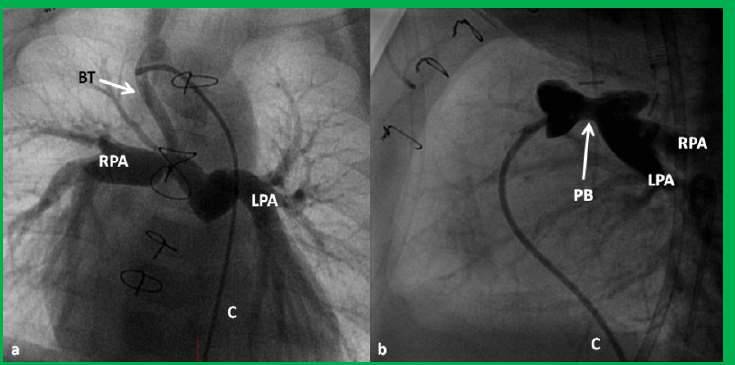
Figure 24. Selected cine frames in postero–anterior ( a ) and lateral ( b ) views, demonstrating a Blalock–Taussig (BT) shunt (arrow in a) to care for infants with decreased pulmonary blood flow ( a ) and pulmonary artery banding (PB) (arrow in ( b )) in babies with increased pulmonary blood flow ( b ), respectively, during Stage I of Fontan procedure. C, catheter; LPA, left pulmonary artery; RPA, right pulmonary artery. Neonates with adequate pulmonary blood flow do not need any intervention and can go directly to Stage II at about the age of 3 months. Reproduced from Rao PS, Indian J Pediatr 2015;82:1147-56 [36].